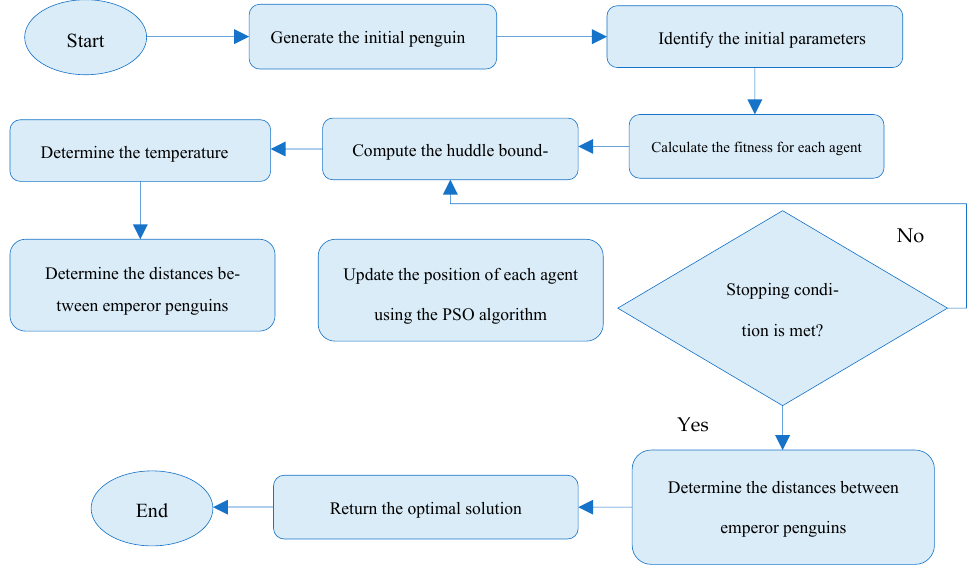
Figure 3. Hybrid EPC and PSO fl owchart .